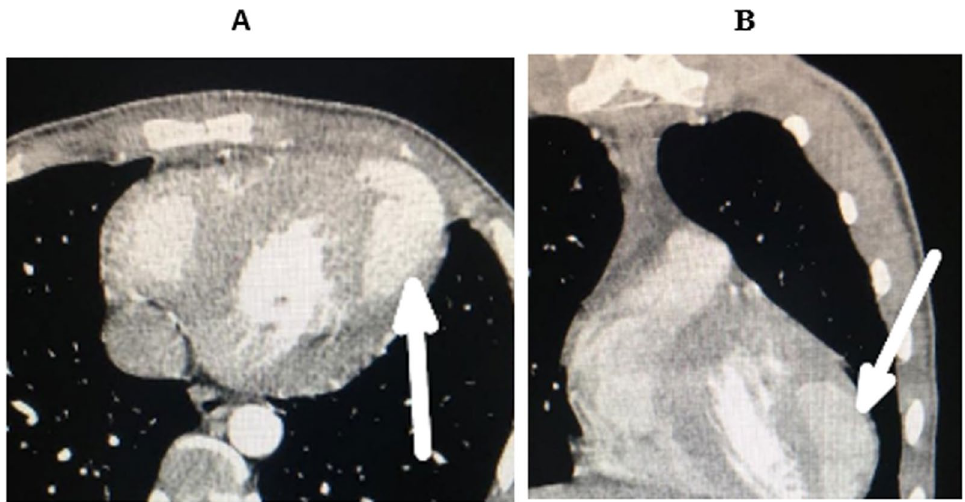
Fig. 2 Computed tomography angiography of the chest showing the pseudoaneurysm of the left ventricular free wall (arrow). a axial view. b coronal